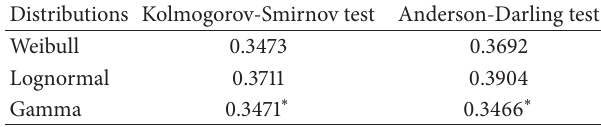
Table 6: Fitted distribution type and goodness of fit statistics.